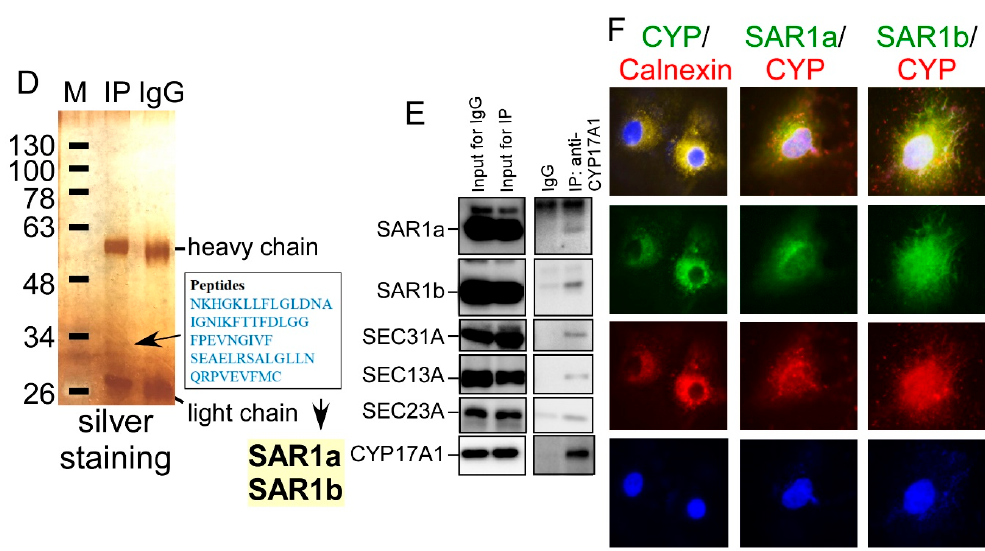
Figure 4. CYP17A1 interacts with secretion-associated Ras-related GTPase (SAR) 1a/b to regulate protein stability in ER. ( A , B ) Cells were analyzed by western blotting using antibodies targeting SAR1a, SAR1b, and SRP14. Quantitative results were expressed as a relative value ± SEM (** p < 0.01 and *** p < 0.001 indicate the significant difference in SAR1a protein expression between the control group without Abi treatment and other groups with Abi treatment; ###p < 0.001 and $$$ p < 0.001 indicate the significant difference in SAR1b and SRP14, respectively). ( C ) After transfection with DDK–Myc–CYP17A1, cells were treated with 20 μ M cycloheximide (CHX) for indicated intervals. Cell lysates were analyzed by western blotting for SAR1a, SAR1b, and SRP14. Right panel: quantitative results. (* p < 0.05, ** p < 0.01). ( D ) Immune complex precipitated by the anti-CYP17A1 antibody was analyzed by silver staining. The arrow-indicated band was scooped out and transferred to proteomics analysis. Peptide sequences identified by LC-MS / MS were listed. ( E ) The immune complex was analyzed by western blotting, using the indicated antibodies. ( F ) After fixation and permeabilization, A172 cells were immunofluorescently stained using antibodies targeting CYP17A1 (CYP), SAR1a, SAR1b, and